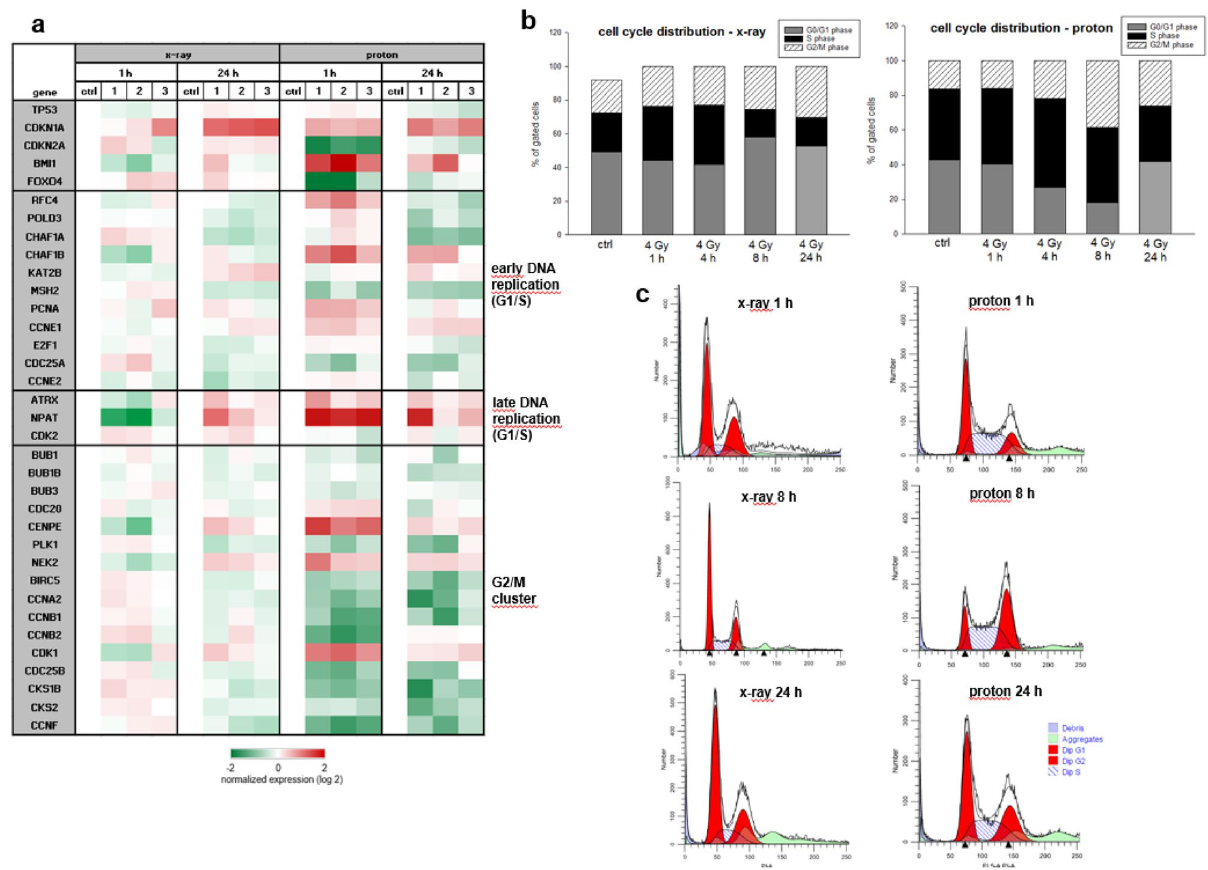
Figure 2. Cell cycle analysis. ( a ) Heatmap blot of RNA sequencing data of relevant cell cycle regulator genes presented in log2 fold-change after photon (X-ray 6 Gy; left) and proton (4 Gy; right) IR (n = 3). ( b ) Cells were analysed using flow cytometry 1 h, 4 h, 8 h, and 24 h after X-ray or proton IR. The corresponding statistical evaluation shown in stacked bar charts (n = 5). 4 h and 8 h after proton IR the cells are clearly arrested in the G2/M phase, whereas after 24 h this effect is largely reversed. X-ray irradiated cells showed hardly any effects. ( c ) Representative original tracks of non-IR control cells (ctrl) and the photon X-ray respectively proton irradiated samples (4 Gy) are